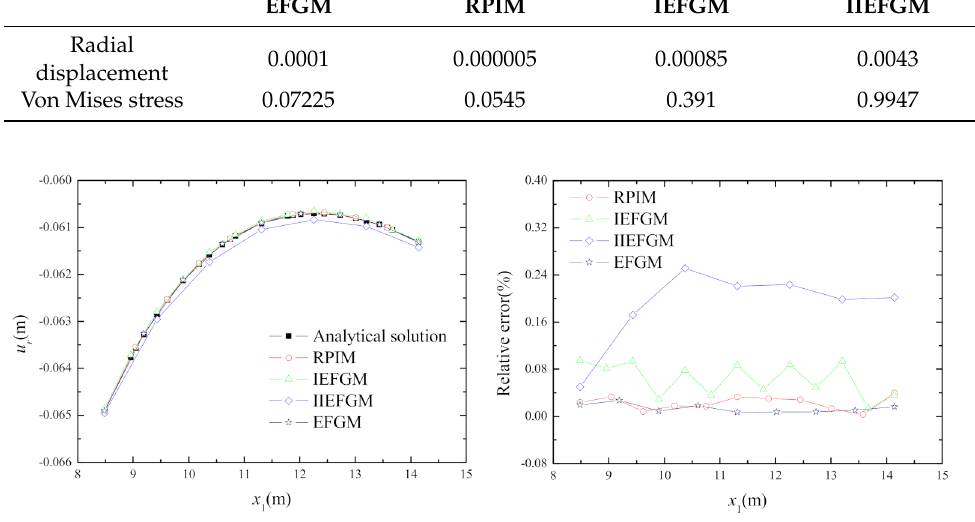
Figure 9. Radial displacement u r and relative error at θ = 45 ◦ of the ring.